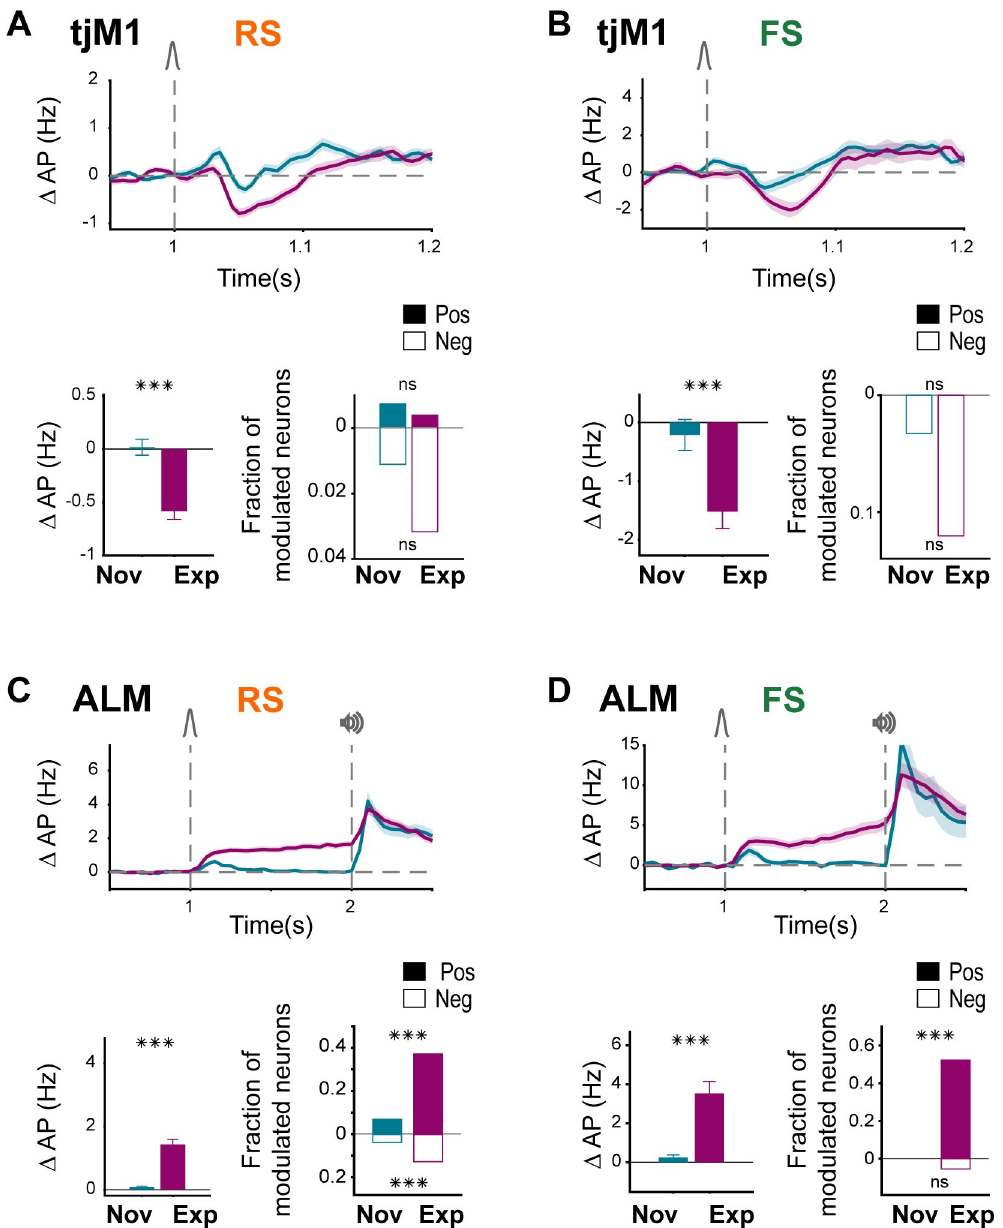
Fig 7. FS neuronal responses in tjM1 and ALM changed similarly to RS neurons. (A) Suppression of tjM1 RS neurons in Expert mice. Top: baseline-subtracted (50 ms before whisker onset) firing rate (mean ± SEM) overlaid for Novice (271 RS units in 8 mice) and Expert mice (505 RS units in 11 mice). Bottom: Comparison of whisker-evoked response in Novice and Expert mice. Bar plots showing population rate in 40- to 90-ms window (mean ± SEM) after whisker onset and statistical comparison using nonparametric permutation test (left, ��� : p < 0.001); fraction of positively (filled bars) or negatively (empty bars) modulated neurons in the same window (right). Modulation of individual neurons compared to a similar window size prior to whisker onset, was identified using nonparametric permutation test ( p < 0.005). Fraction of modulated neurons in Novice and Expert were compared using a chi-squared proportion test (ns: p > = 0.05). (B) Suppression of tjM1 FS neurons in Expert mice. Panels are similar to (A) but for tjM1 FS neurons in Novice (61 neurons in 8 mice) and Expert mice (83 neurons in 11 mice). (C) Delay activity of RS neurons in Expert mice. Top: baseline-subtracted (1 second before whisker onset) firing rate (mean ± SEM) overlaid for Novice (234 RS units in 6 mice) and Expert mice (766 RS units in 12 mice). Bottom: Comparison of whisker-evoked response in Novice and Expert mice. Bar plots showing population rate in 200- to 1,000-ms window (mean ± SEM) after whisker onset and statistical comparison using nonparametric permutation test (left, ��� : p < 0.001); fraction of positively (filled bars) or negatively (empty bars) modulated neurons in the